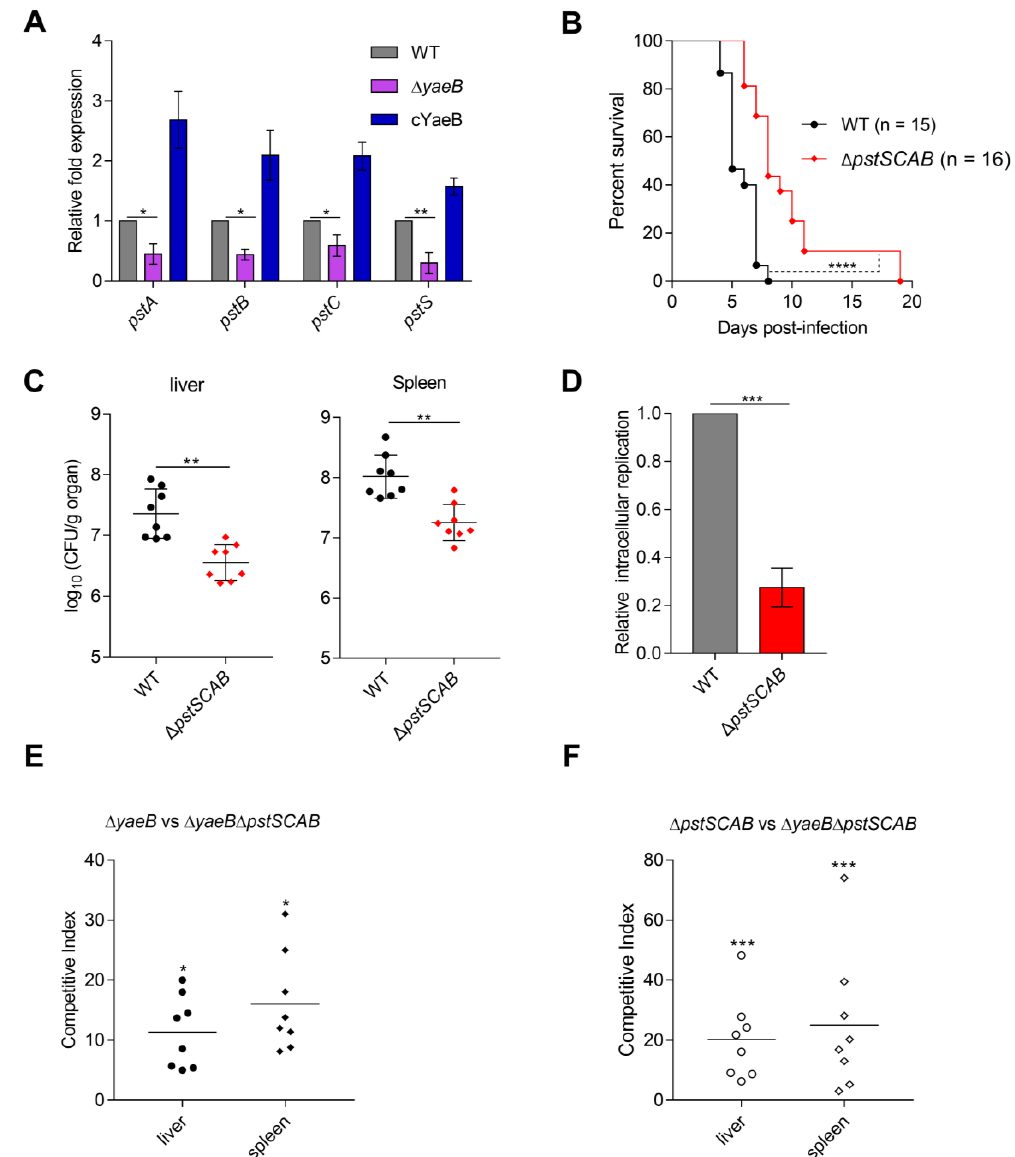
Figure 3. YaeB influenced virulence by activating pstSCAB genes. ( A ) Deletion of yaeB reduced the transcription of pstSCAB genes. Fold changes in gene transcription in the yaeB mutant or cYaeb strain relative to their expression in the WT strain are shown. Student’s t -tests were used to calculate P values. * P < 0.05; ** P < 0.01. ( B ) Mice were infected by i.p. injection with 2 × 10 4 CFU of the WT strain or pstSCAB mutant to monitor for survival. Log-rank curve comparison tests were used to calculate P values. **** P < 0.0001. ( C ) Bacterial counts recovered from the livers and spleens of mice injected i.p. with the WT or pstSCAB mutant strain at 3 dpi. Bars represent mean CFU of all mice, and significance was determined by Mann – Whitney U tests. ** P < 0.01. ( D ) Growth of the WT strain or pstSCAB mutant strain in macrophages was determined by the ratio of the count of intracellular bacteria at 16 hpi to the count of bacteria at 2 hpi. The replication abilities of the mutant were calculated relative to that of the WT strain. Student’s t -tests were used to calculate P values. *** P < 0.001. ( E , F ) BALB/c mice were infected by i.p. injection with either a 1:1 mixture of the yaeB mutant and the yaeB / pstSCAB double mutant ( E ), or a 1:1 mixture of the pstSCAB mutant and the yaeB / pstSCAB double mutant ( F ) 2 × 10 4 CFU in total, and sacrificed at 3 dpi for enumeration of bacterial burdens. CI values were determined in the liver and spleen. The data represent results combined from two independent experiments. The Mann – Whitney U test was used to calculate P values on raw CFU values, * P < 0.05; *** P < 0.001.